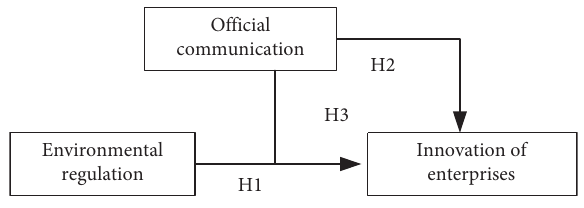
Figure 1: Research idea